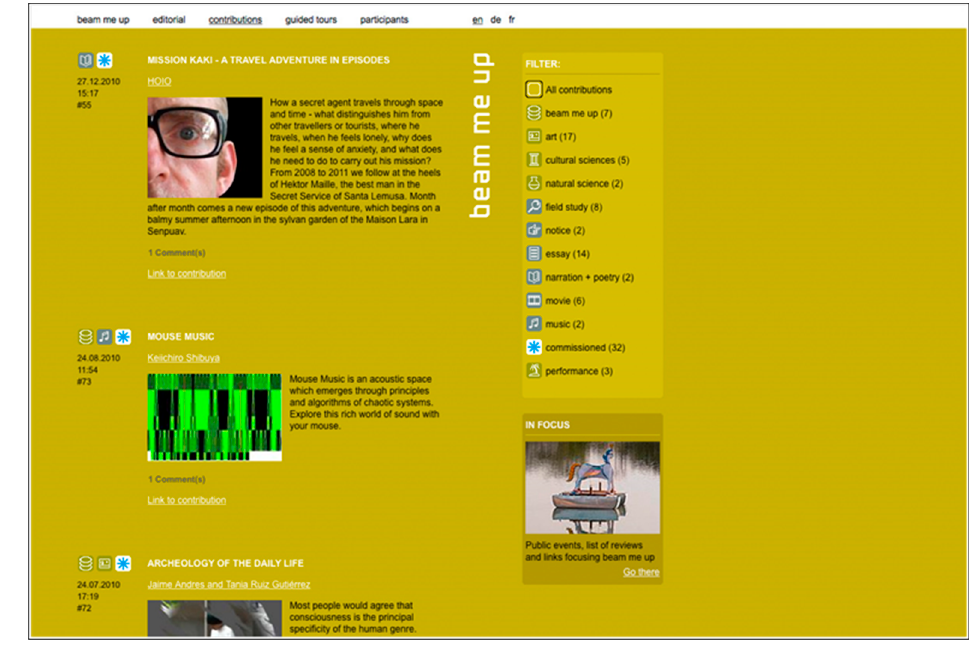
Figure 12. Beam Me Up, 2009. Screenshot of contribution page, 2015. © Reinhard Storz, 2019.